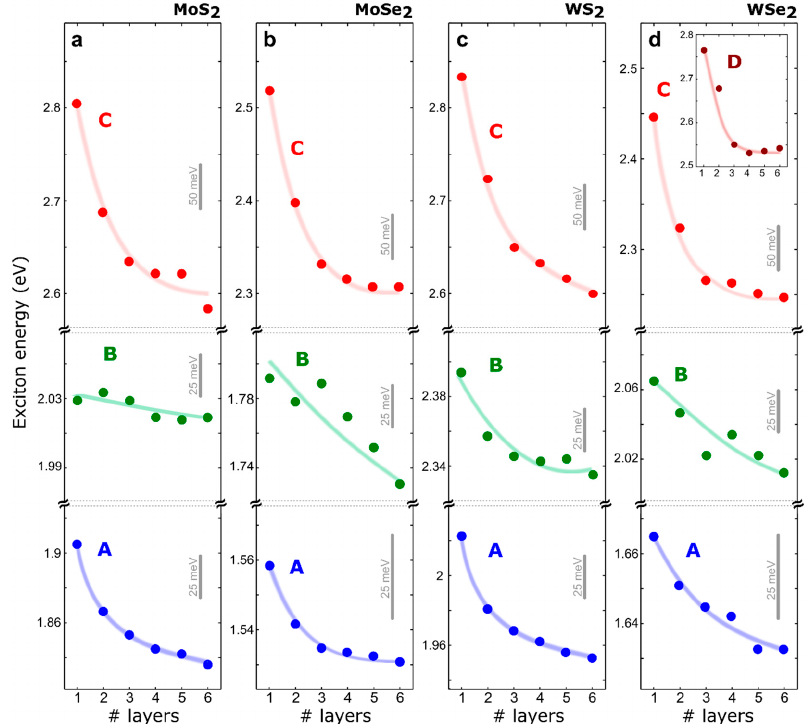
Figure 3. Thickness dependence of the exciton energies, extracted from the measured differential reflectance spectra of ( a ) MoS 2 , ( b ) WS 2 , ( c ) MoSe 2 , and ( d ) WSe 2 . The solid lines are guides to the Table 1. Comparison of the spin ‐ orbit splitting extracted from the differential reflectance spectra, and those obtained from ab initio calculations, including spin ‐ orbit interaction.